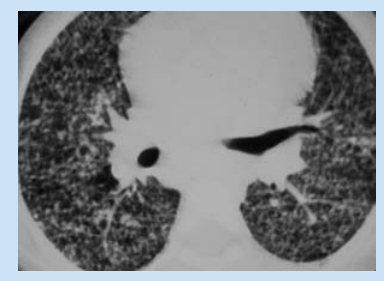
Fig.14. Miliary TB.